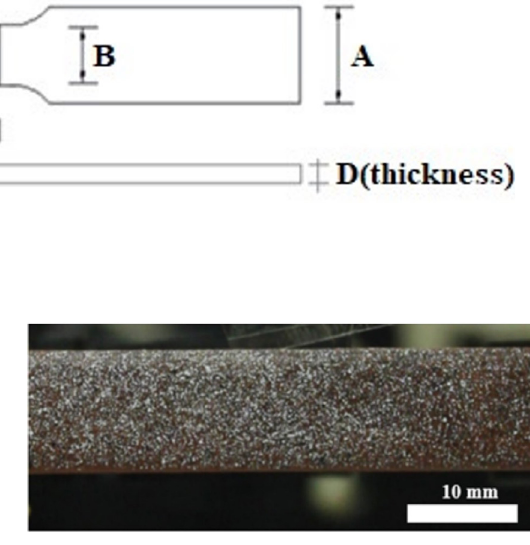
Figure 3. Speckle pattern applied on polyester/red mud